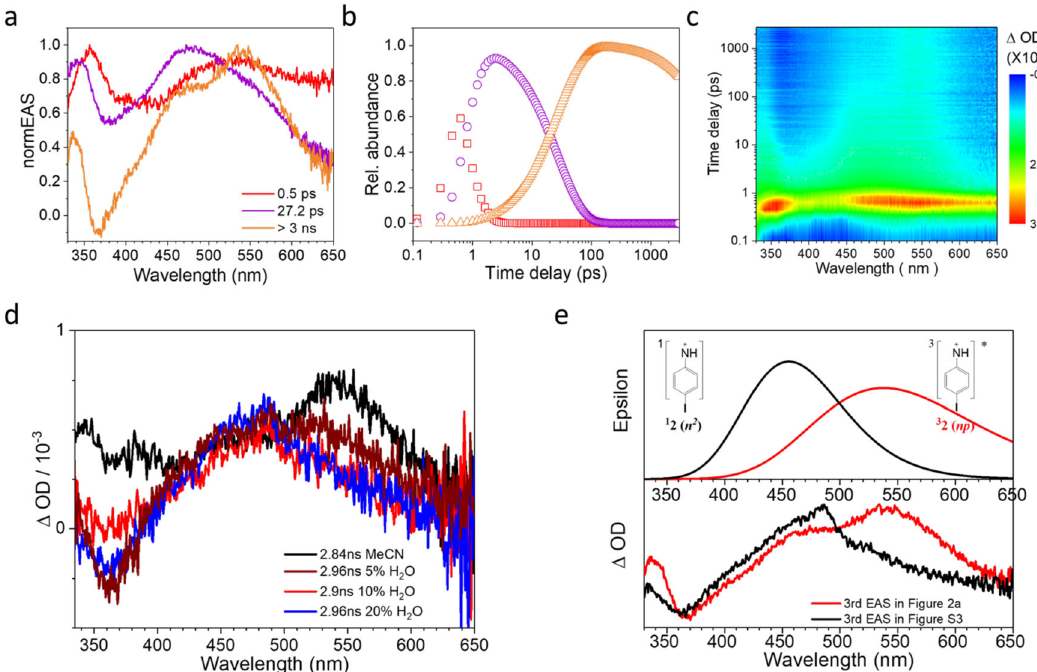
Fig. 2 Femtosecond transient absoprtion spectroscopy (fs-TA) spectra of the precursor 1 after 267 nm excitation in MeCN. a normalized- Evolution Associated Difference Spectra (EAS) according to the sequential kinetic models, ( b ) time evolution of the state population obtained from the global fi tting analysis and the color of the fi tting trace is consistent with the EAS spectra represented in Fig. 2a, ( c ) contour plots of the time-resolved absorption spectroscopic responses, ( d ) comparison of the third EAS spectra obtained in different percentages of water in MeCN, ( e ) the comparism of the experimental data (bottom) and the calculated UV – vis spectra(top): the 3rd EAS spectrum in Fig. 2a (bottom, red) and the 3rd EAS spectrum in Supplementary Fig. 3 (bottom, black), computed UV-vis spectra of the triplet 4-iodophenylnitrenium ion 3 2 ( np ) (top, red) and closed-shell 4- iodophenylnitrenium ion 1 2 ( n 2 ) (top, black) obtained by CASPT2//CASSCF/PCM/cc-pVDZ calculations. The Cartesian Coordinates of the computed structures are shown in the Supplementary Data